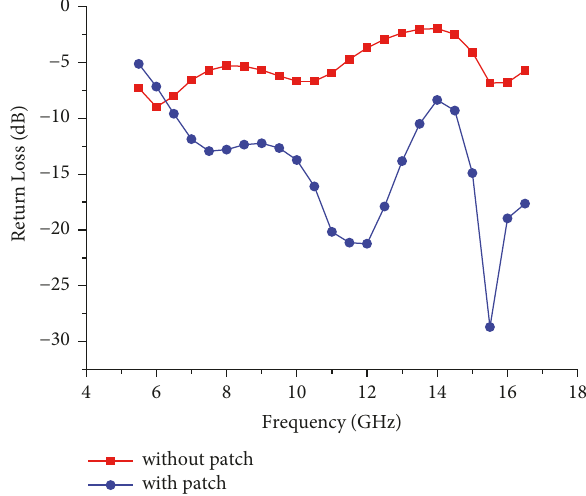
Figure 3: Return loss comparison (with and without metal patch) of the DRA element.